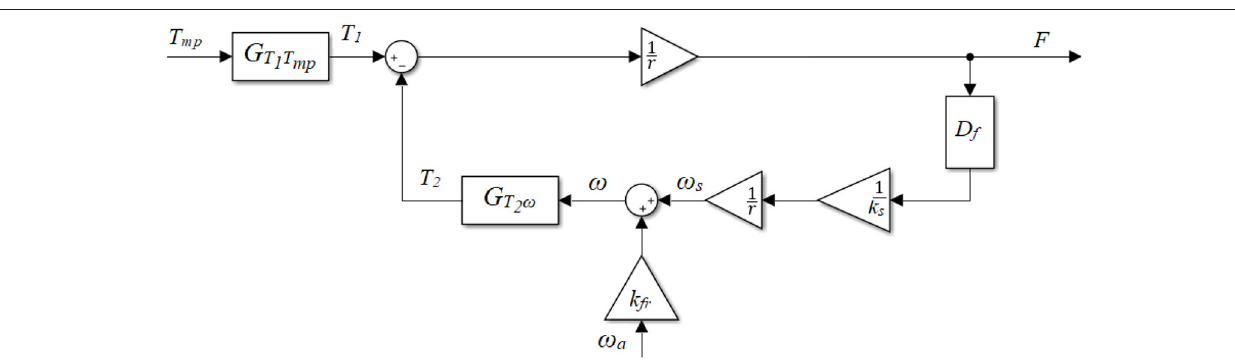
Frontiers in Neurorobotics |